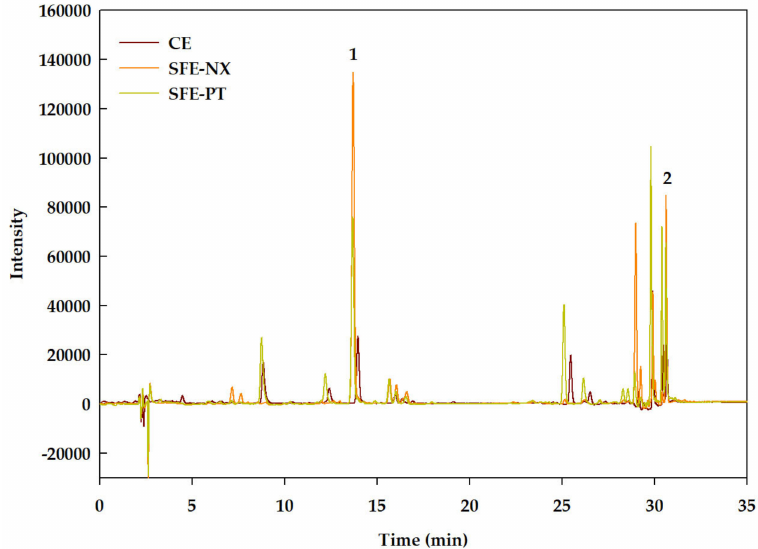
Figure 3. HPLC-DAD profile of the optimized supercritical fluid (SFE) and conventional (CE) extracts derived from Parthenon (SFE-PT) and Naxos (SFE-NX) broccoli by-products, acquired at 454 nm. 1: Lutein; 2: β -Carotene.